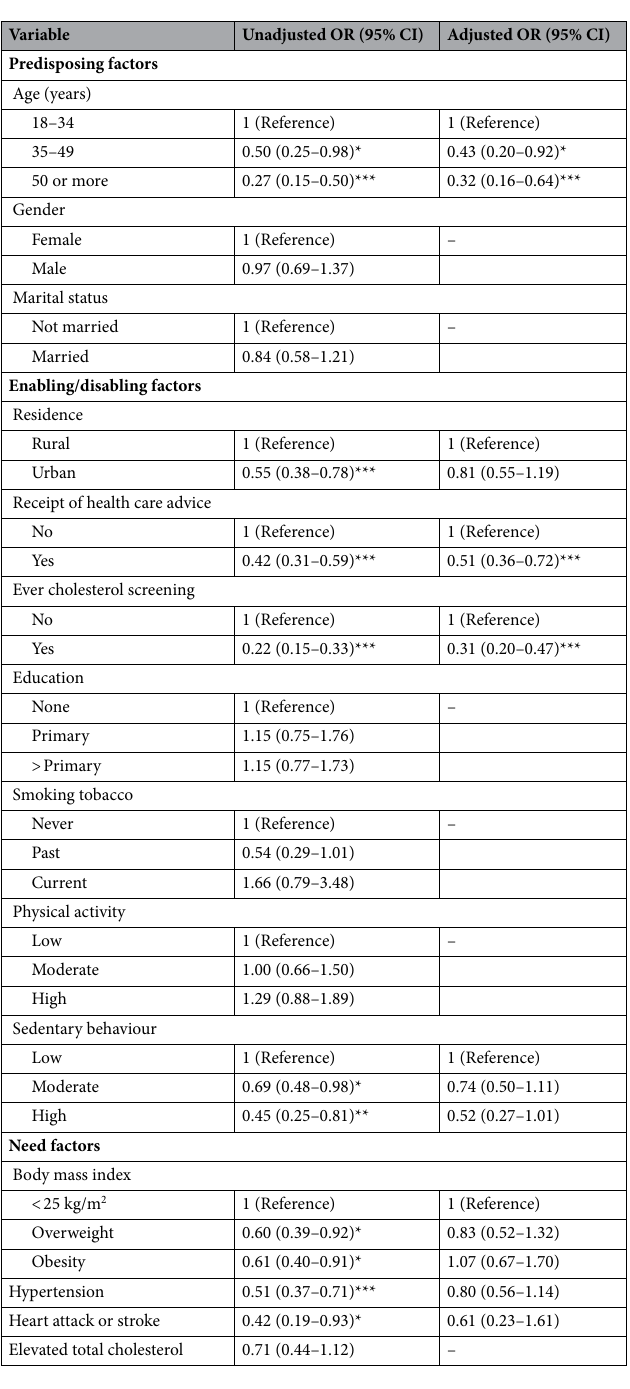
Table 4. Unadjusted and adjusted Odds Ratios (OR)for factors associated with diagnosed or undiagnosed type 2 diabetes (T2D) in Moroccan adults, 2017. OR Odds ratio, CI Confidence intervals. * p < 0.05; ** p < 0.01; *** p <